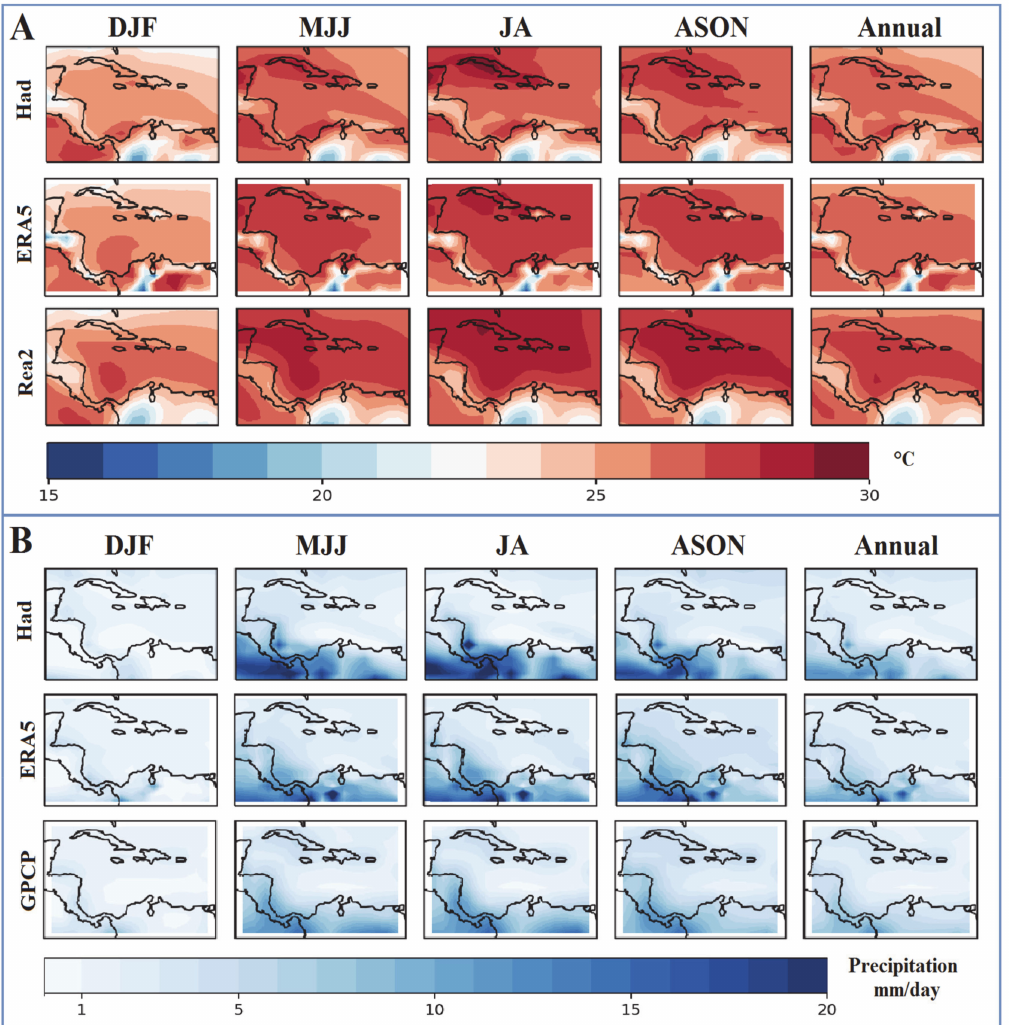
Figure 5. Annual and seasonal climatology plots of air temperature (panel A ) and precipitation (panel B ) for the Caribbean for the period 1985 to 2005. Temperature plots are from HadGEM2-ES (row 1), ERA5 (row 2) and Reanalysis 2 (row 3) datasets. Precipitation plots are from HadGEM2-ES (row 1), ERA5 (row 2) and GPCP (row 3) datasets. Units for panels A and B are ◦ C and mm/day,